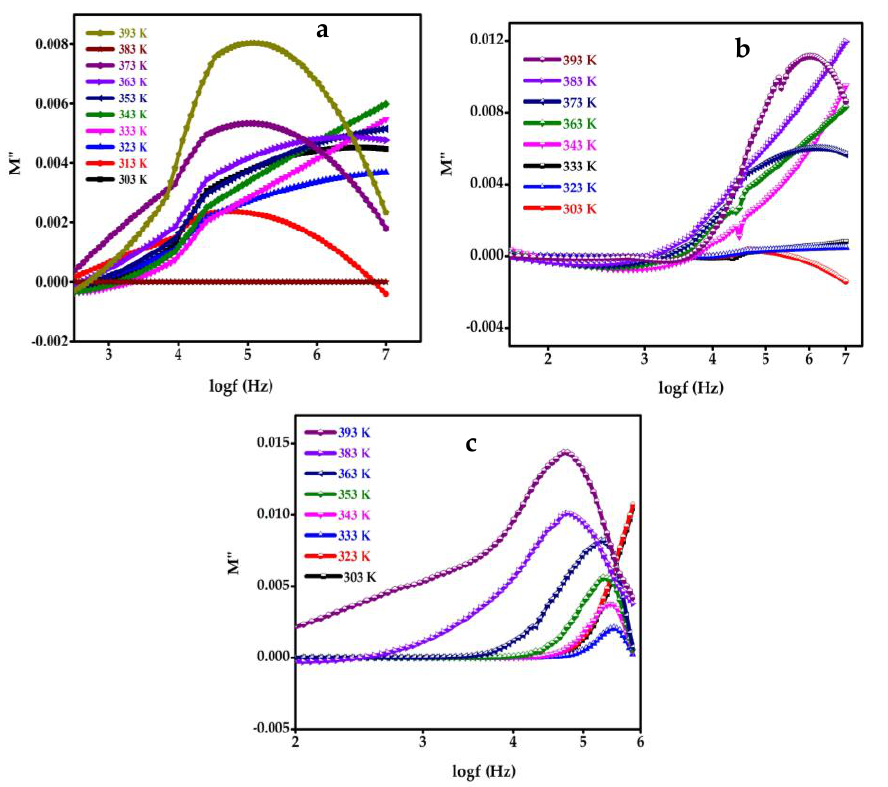
Figure 13. Electric modulus (M”) variation as a function of frequency at different temperatures for ( a ) SnO 2 QDs, ( b ) GO, and ( c ) SGP2 composite